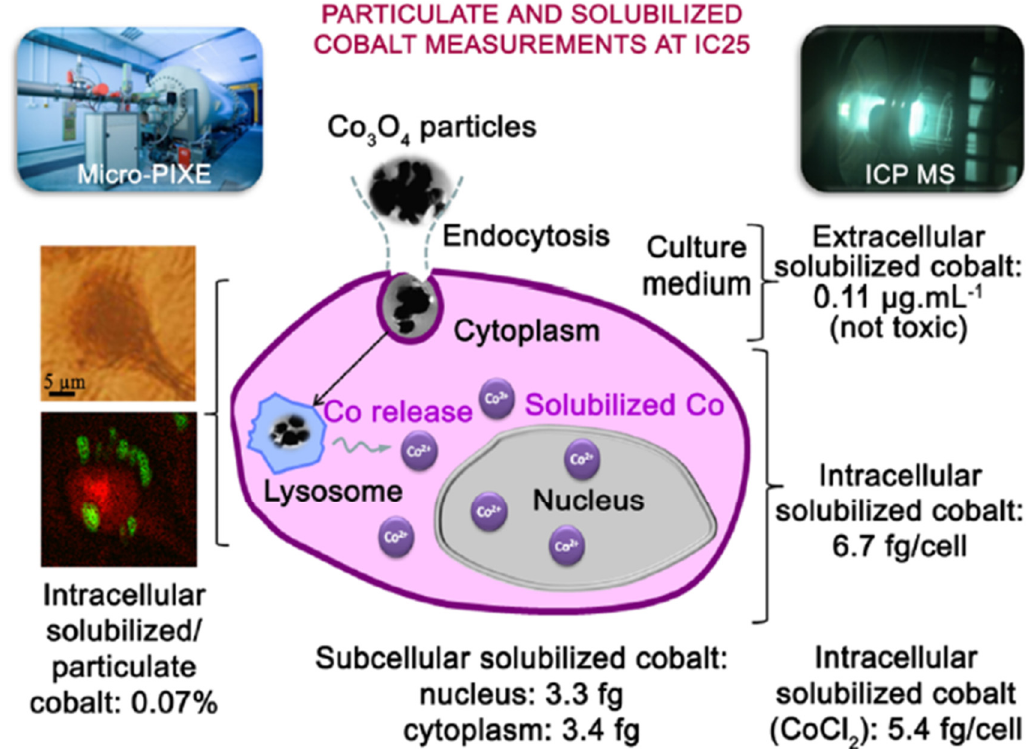
Figure 2. Schematic representation of the analytical methods and the quantification of cobalt internalized in cell compartments. IC 25 : inhibiting concentration 25%; Micro-PIXE: particle-induced X-ray emission; ICP-MS: inductively coupled plasma mass spectrometry. Reproduced from reference 74 with permission of the BioMed Central